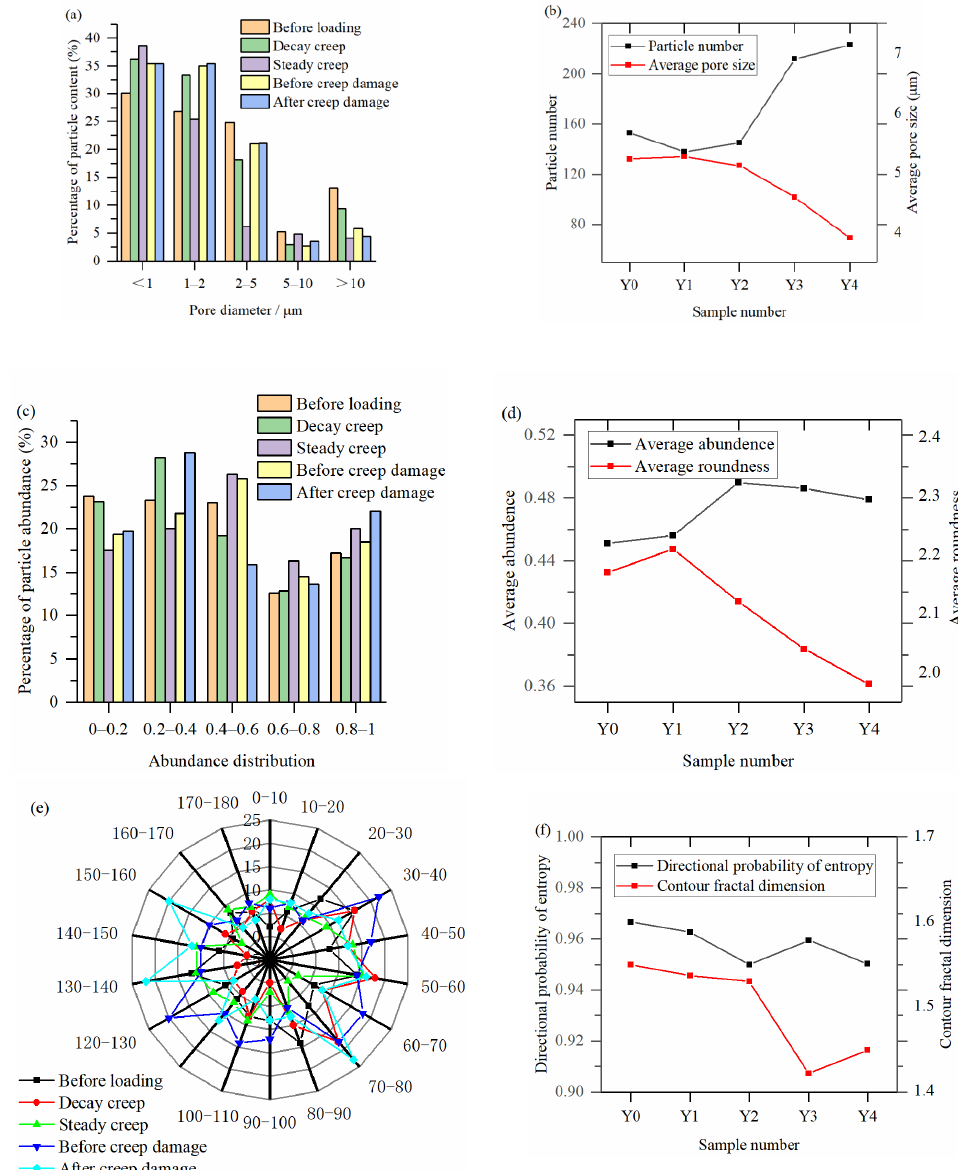
Figure 10. Quantitative analysis of intact soil particles. ( a ) Histogram of particle content; ( b ) number of particles and average particle size; ( c ) particle abundance distribution; ( d ) average particle abundance and roundness; ( e ) particle orientation probability distribution; ( f ) particle orientation probability and fractal dimension.